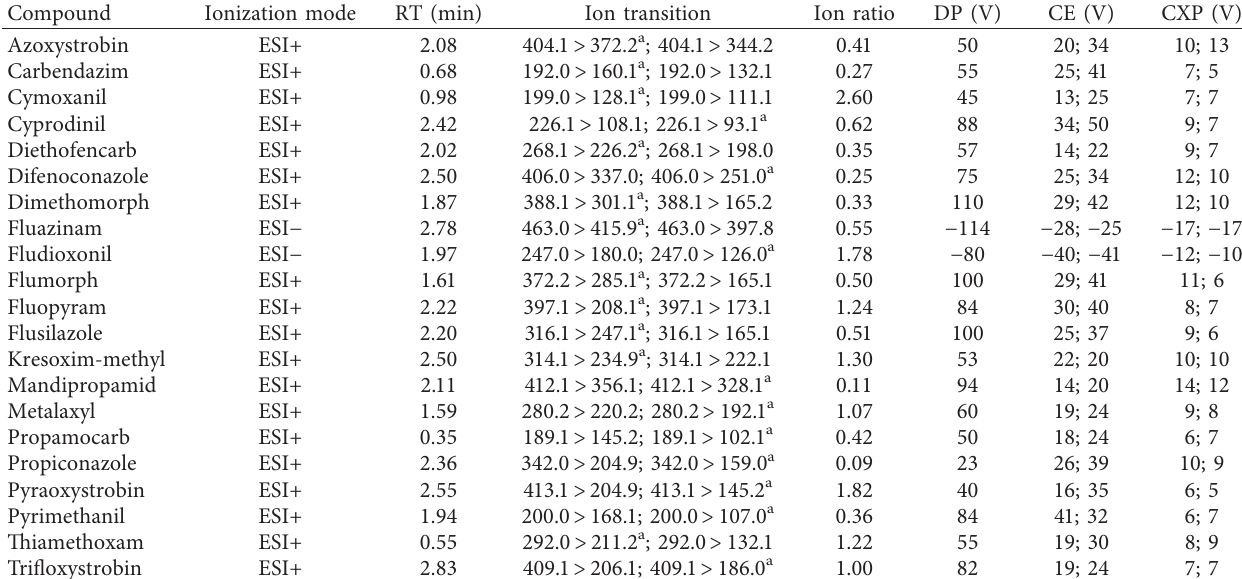
Table 1: MS/MS detection information of 21